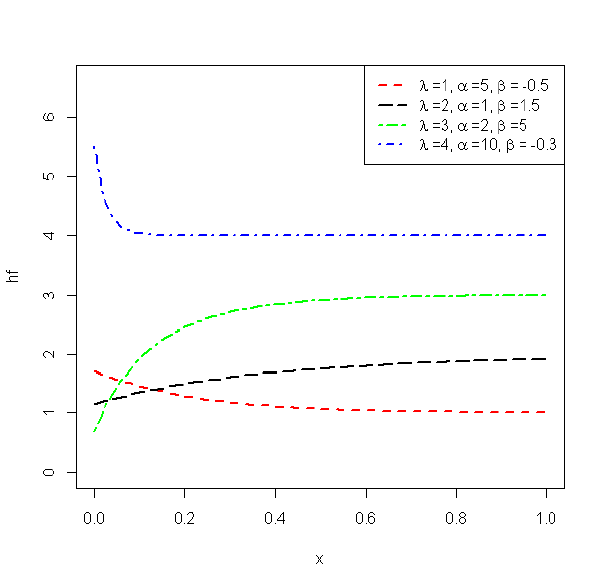
Figure 2. The hazard function curves for different values of parameter in GME ( λ , α , β )